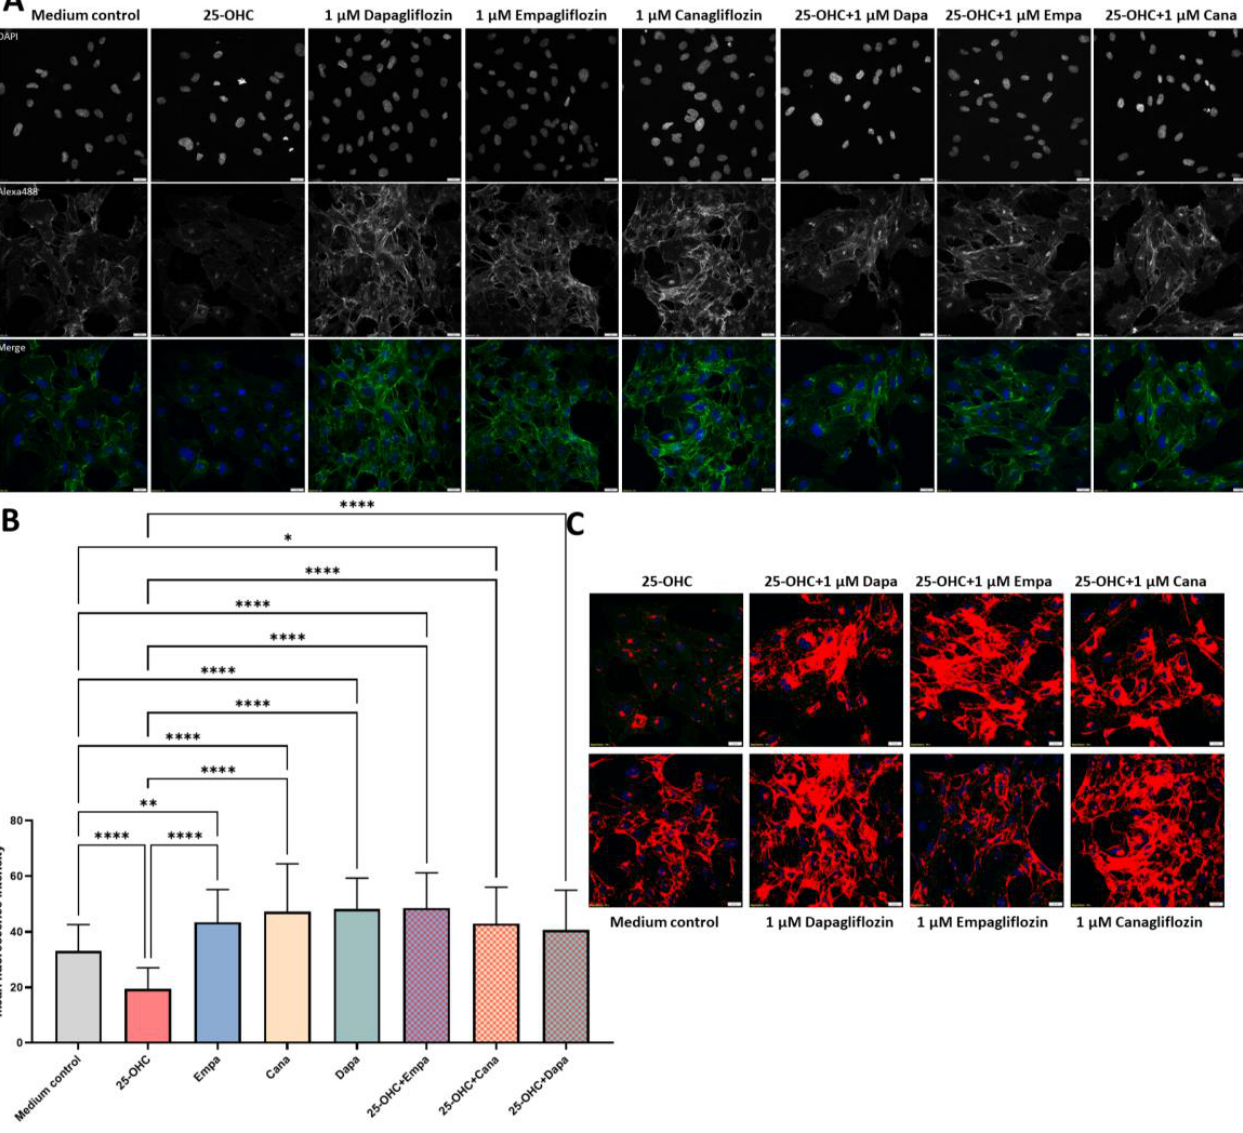
Figure 3. The expression and distribution of VE-cadherin in endothelial cells after treatment with 25-OHC and selected flozins . HUVEC cells were treated with medium (control), 10 μg/mL 25 -OHC (4 h), followed by 24 h incubation with or without 1 μM dapagliflozin, empagliflozin, or canagliflozin. ( A ) Cells were stained for VE-cadherin (green) and DAPI (blue). ( B ) Quantification of VE-cadherin protein levels measured as mean fluorescence intensity in cell membrane ( n = 30 – 40